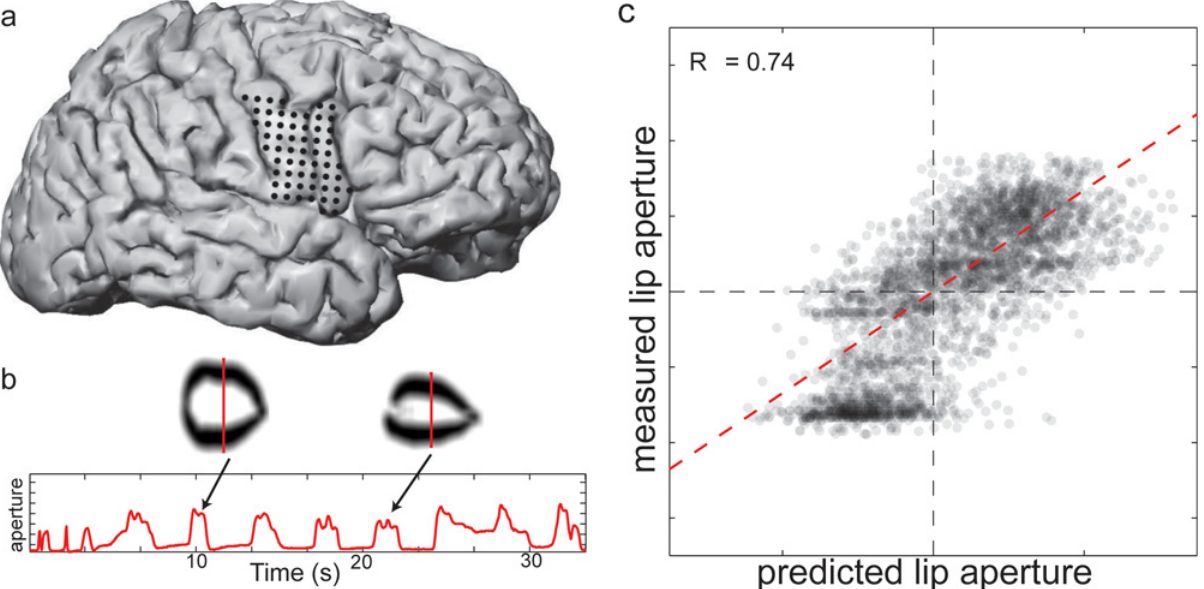
Fig 7. Decoding of lip aperture from ECoG recordings during production of words. a) Lateral view of the right hemisphere of a neurosurgical patient. The location of ECoG electrodes over the ventral sensorimotor cortex are demarcated with grey disks. b) Example lip shape and vertical aperture during production of words in this subject. c) Predicted lip aperture based on linear decoding of ECoG data vs. the actual aperture. Each dot is a time-point; red- dashed line is best linear fit.